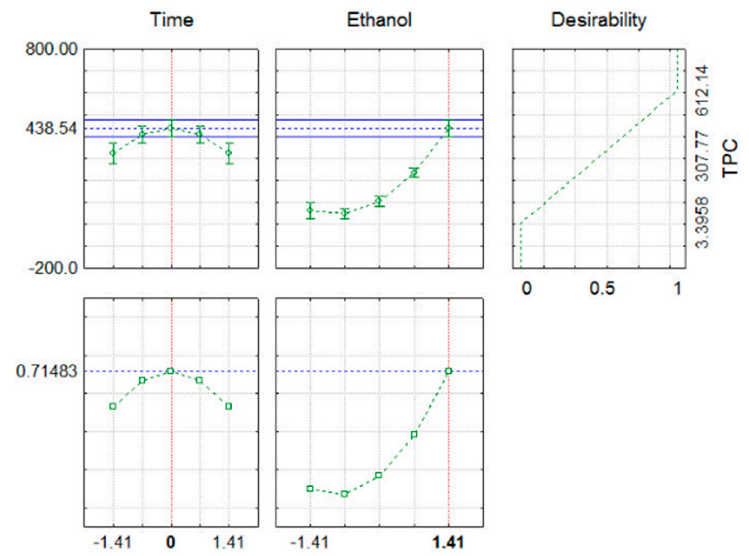
Figure 2. Profiles of predicted values and desirability obtained for the analysis of TPC.